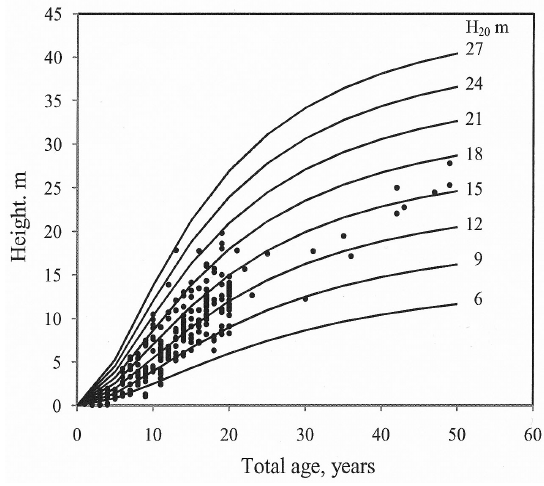
Figure 2. Site index curves (H ) for hybrid larch growing at different locations (lattitude 20 55° to 60° N.) n = 26 stands. Total age.